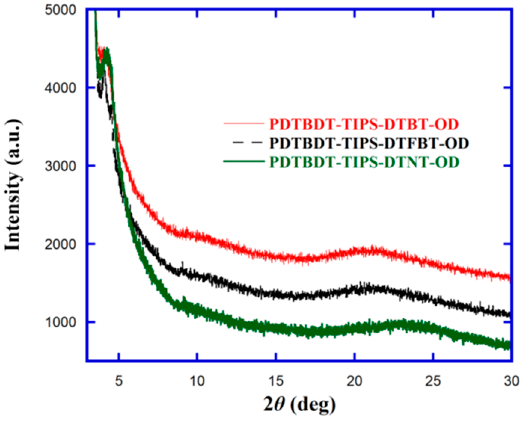
Figure 4. X-ray patterns of copolymers.